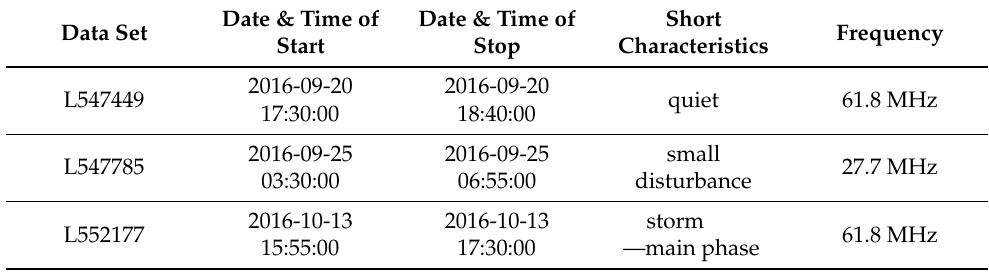
Table 1. Datasets selected for the analysis and description of the geomagnetic conditions over the time of